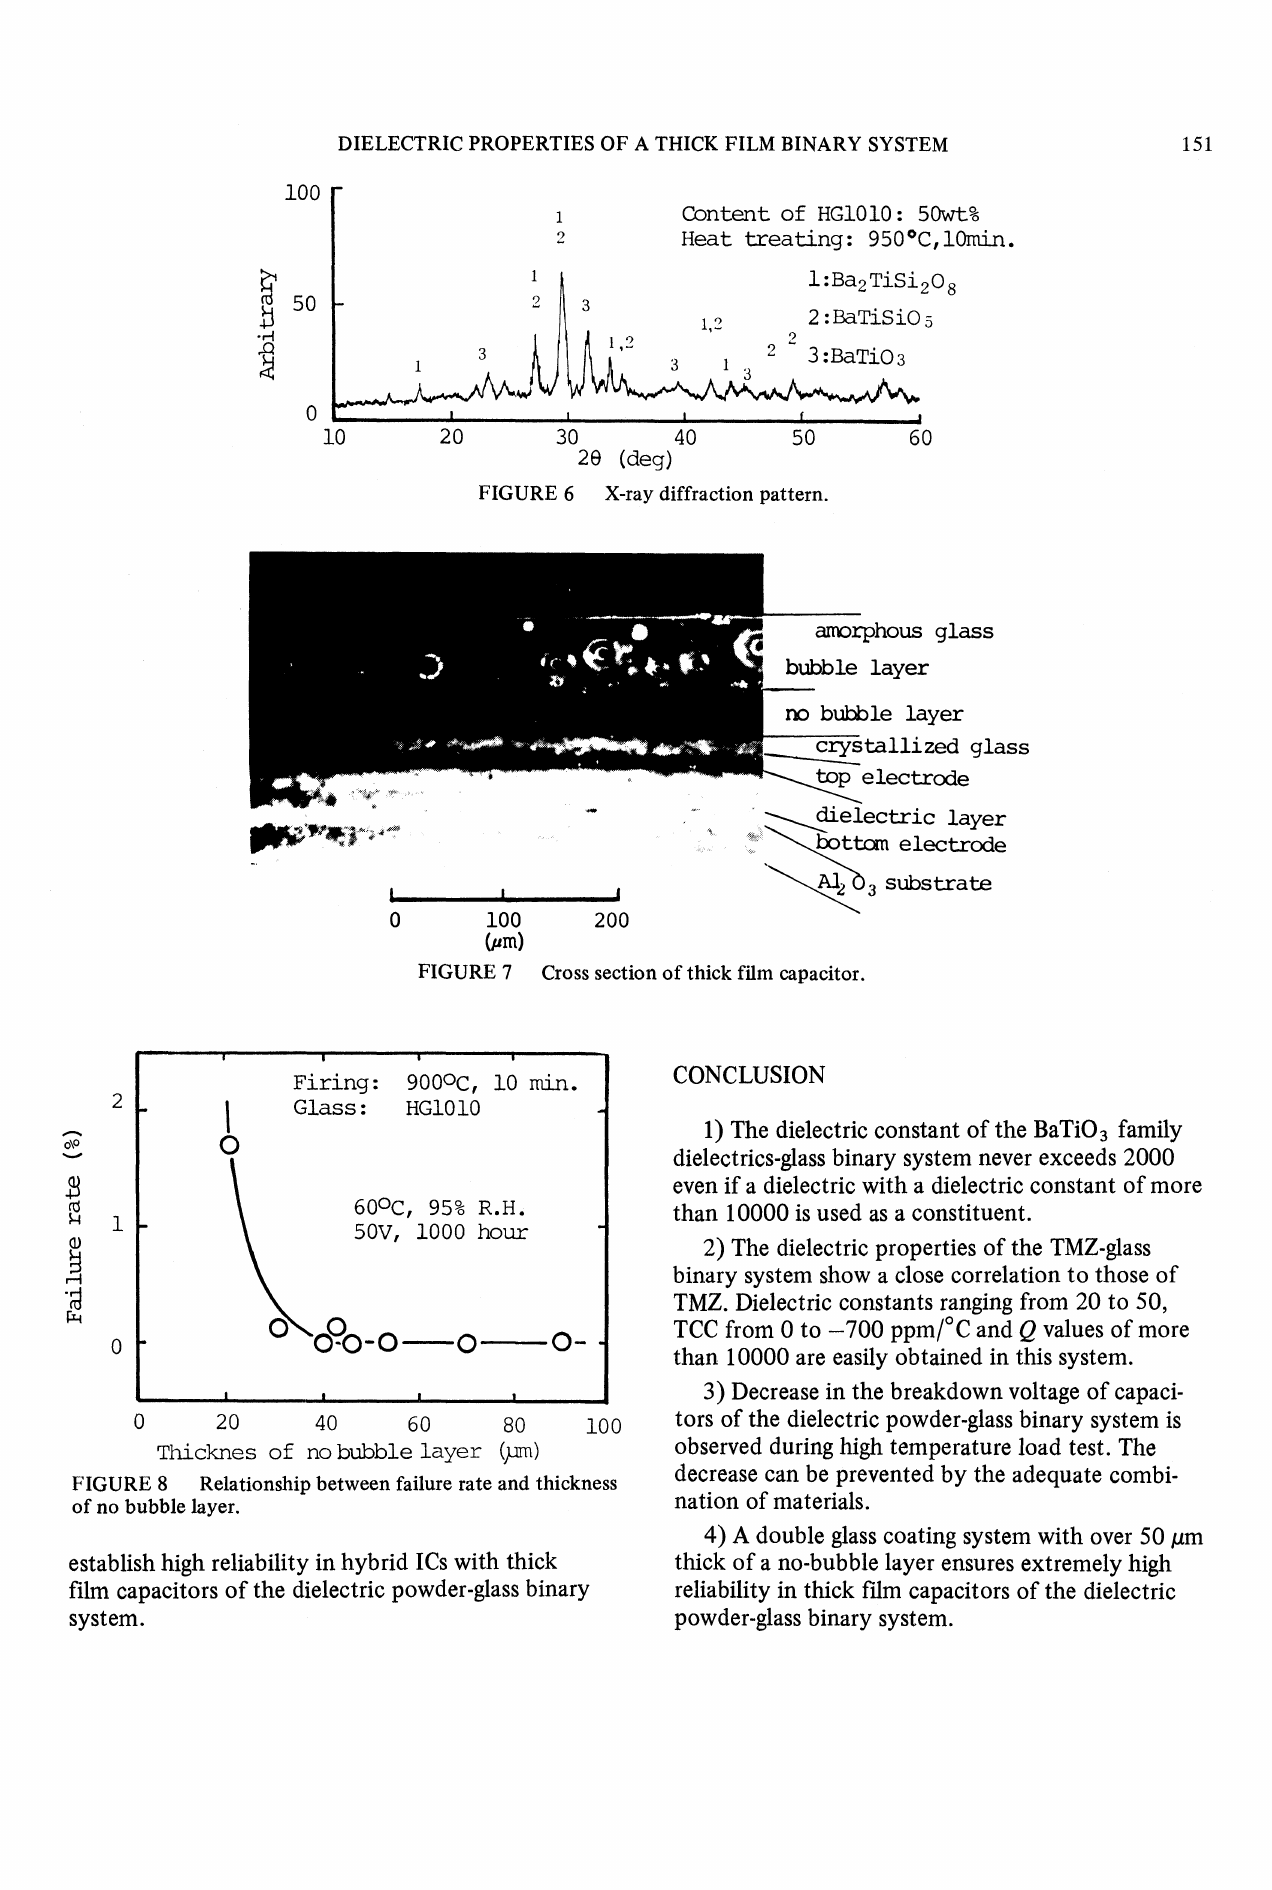
X-ray diffraction pattern.